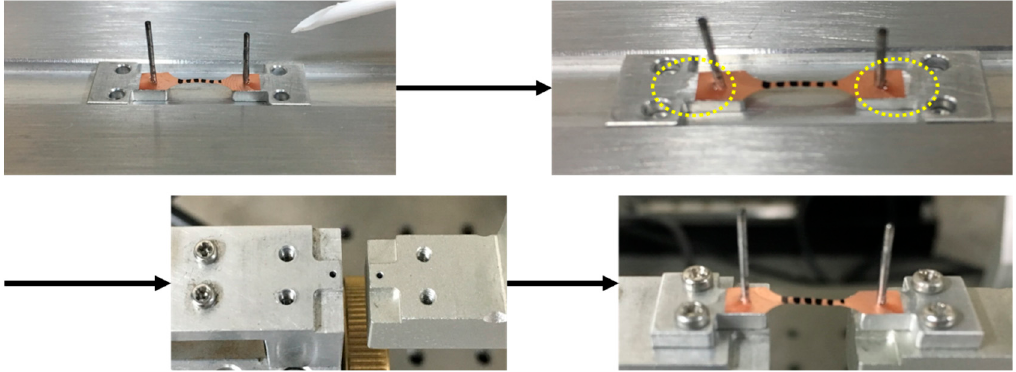
Figure 5. Alignment and attaching process to fix specimen to aluminum plate.